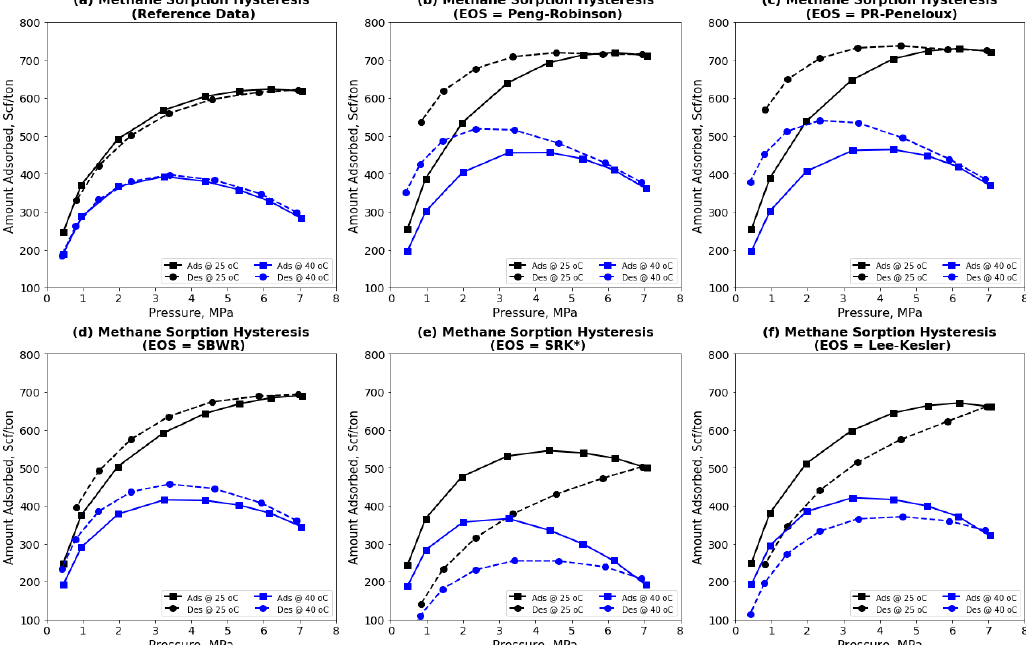
Figure 5. Methane-coal sorption hysteresis by equation of state (* SRK-Peneloux is similar).